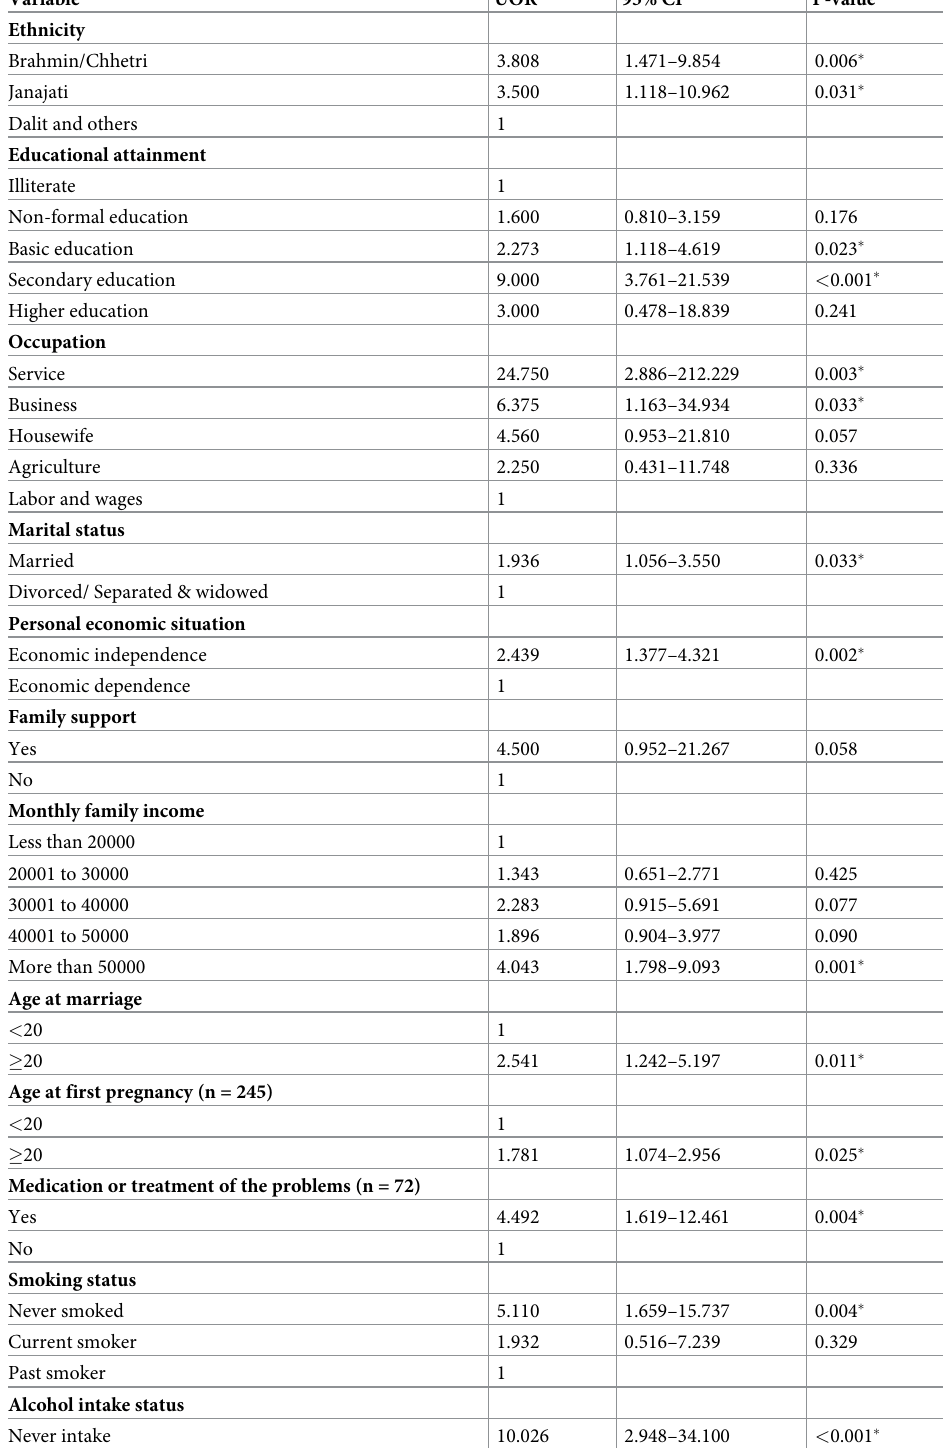
Table 5. Socio-demographic, obstetric, lifestyle-related factors, and health problems associated with quality-of-